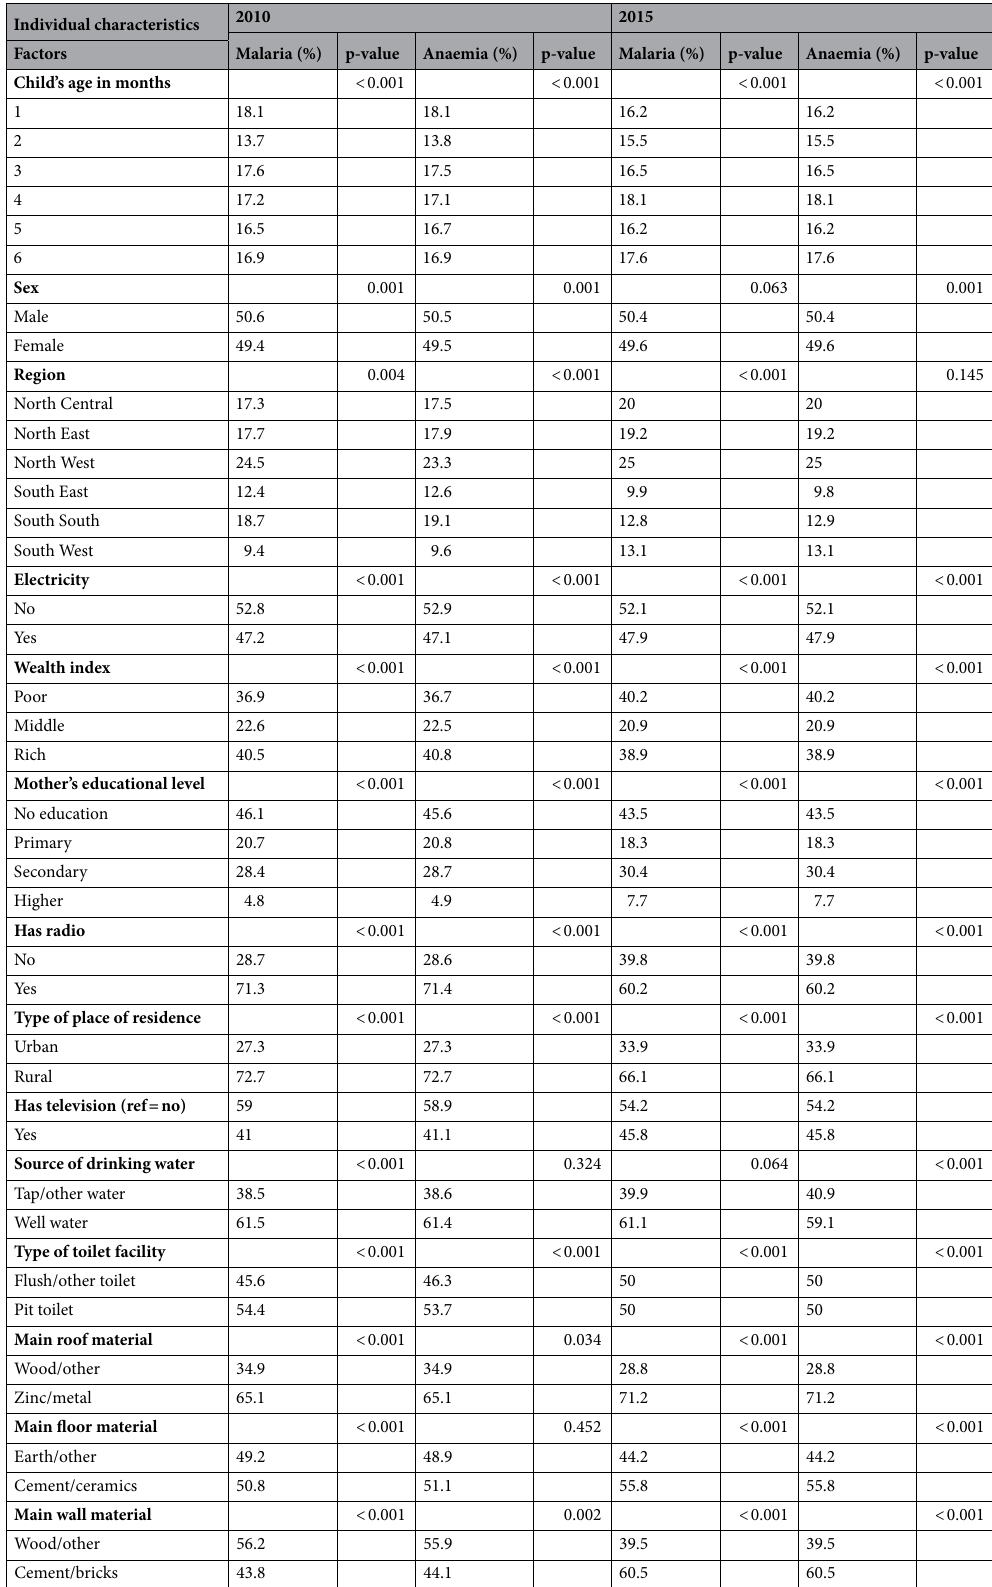
Table 2. Percentage of malaria and anaemia with the p-value of under age 5 years children in 2010 and 2015 for each